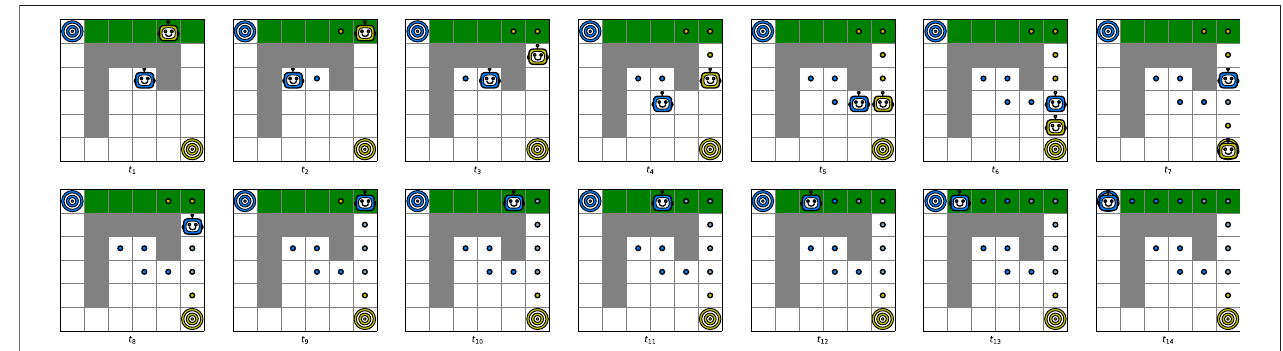
FIGURE5 | Representation ofthe movement of twoagents on asmall map in adeterministic environment. Bothagentshave only four possible actions { up, down, left, right }. The value function is calculated through the DP and both agents have their own